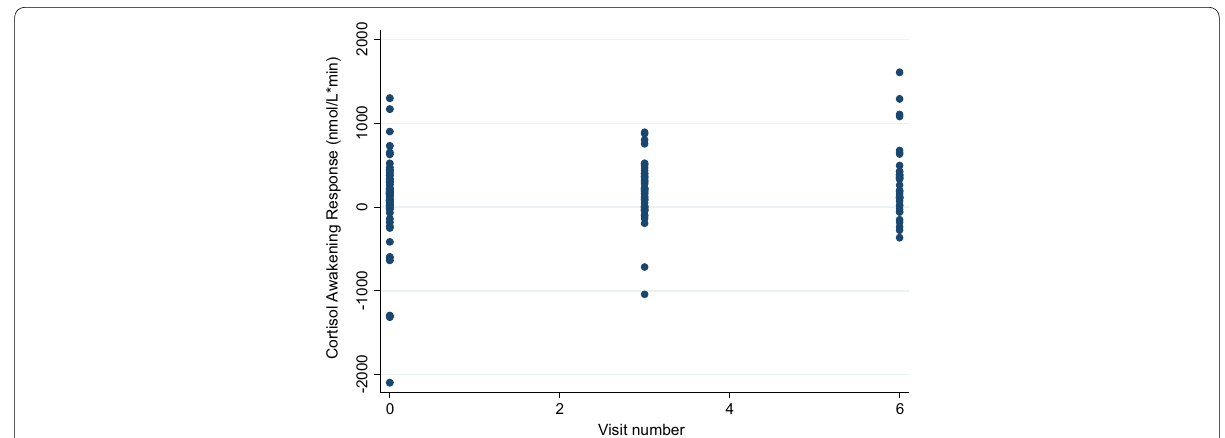
Fig. 1 Scatter plot of CAR and smartphone‑based monitoring of stress. Each dot represents multiple smartphone‑based patient‑reported evaluations of stress level and CAR